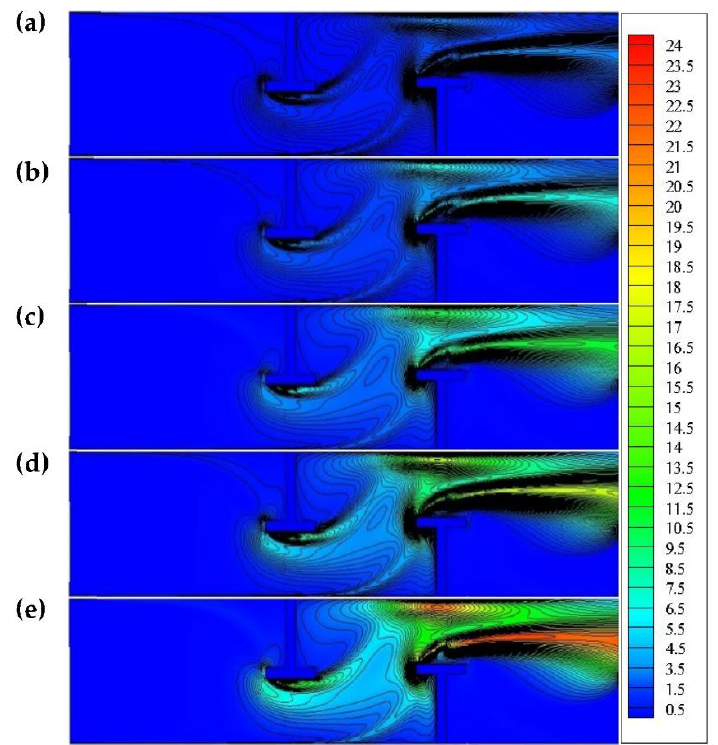
Figure 8. Variation of the turbulent kinetic energy for: Re = ( a ) 12,000; ( b ) 17,000; ( c ) 22,000; ( d ) 27,000; ( e ) 32,000.